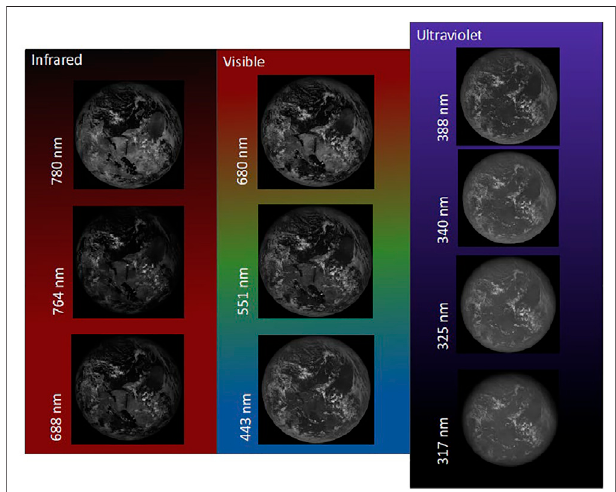
FIGURE 1 | Images of the Earth taken in different wavelength by EPIC. The leftmost panel are infrared bands; middle are visible; right are ultraviolet. The range permits EPIC to engage in land, cloud, and atmospheric studies as well as produce color images.